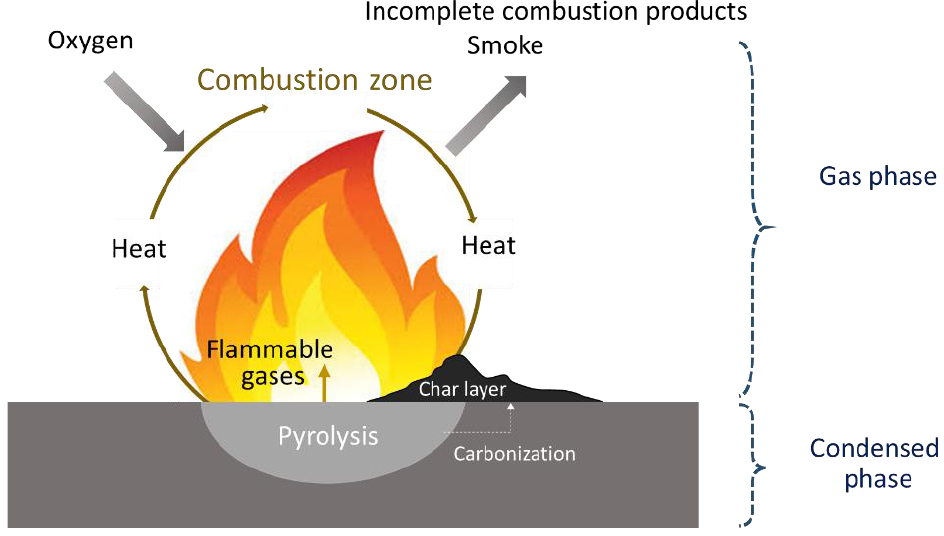
Figure 2. Typical combustion cycle involving a complex coupling of energy feedback from a flame to the combustible degradation products.